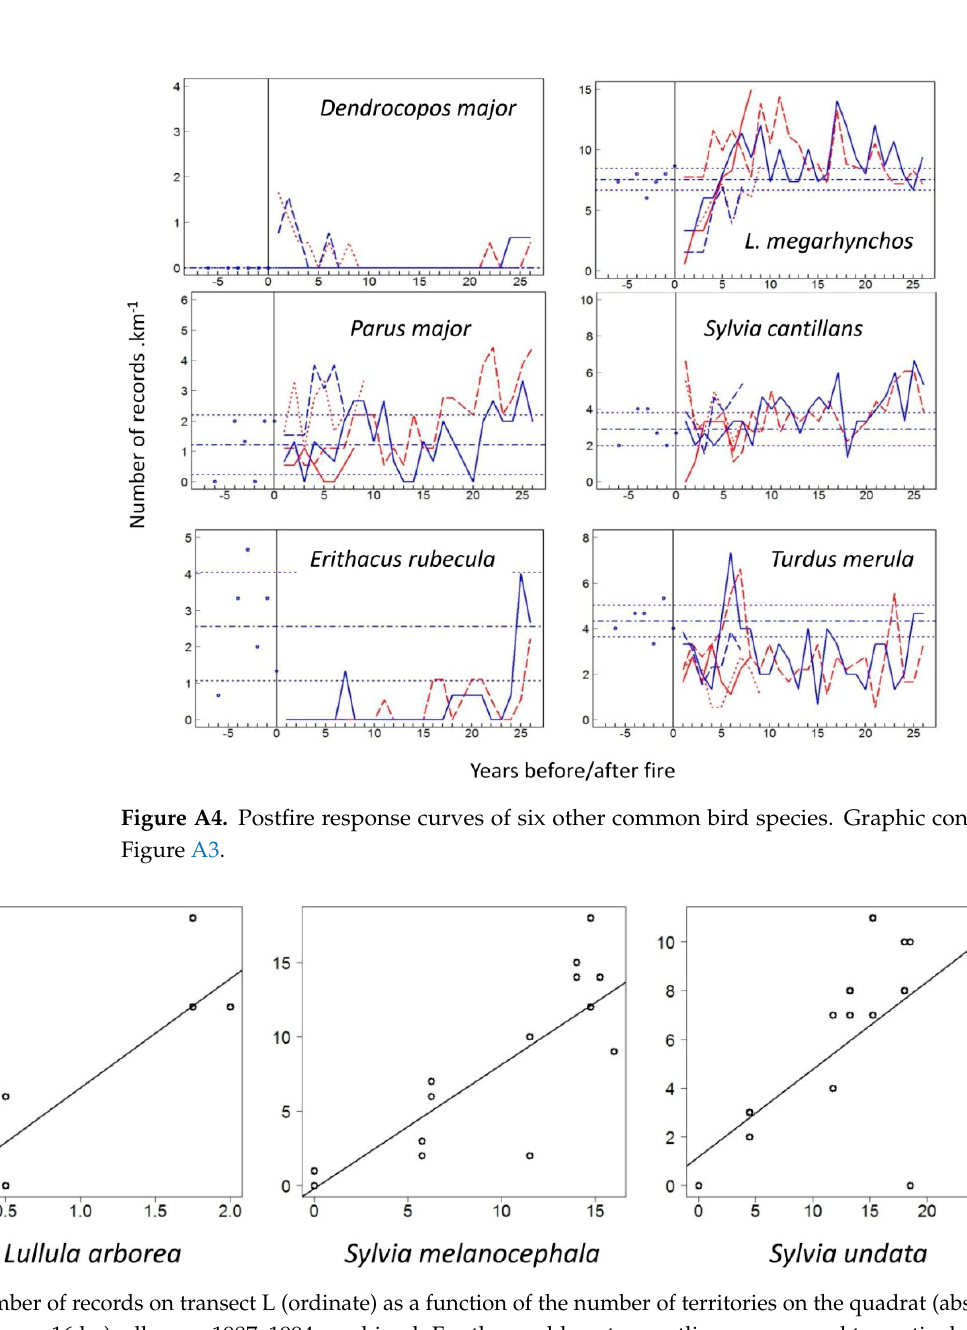
dashed line: second fire; dotted line: third fire. Circles (and dash-dotted line): prefire control (and mean ± sd).